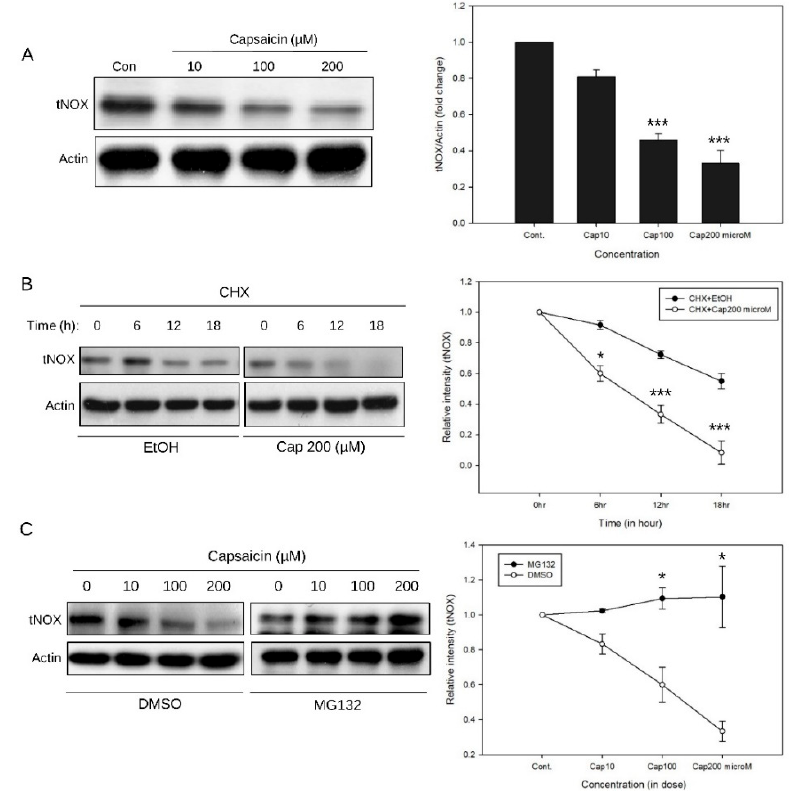
Figure 2. Capsaicin suppresses tNOX expression through proteasome-mediated degradation. Aliquots of cell lysates were separated by SDS-PAGE and analyzed by Western blotting. β -Actin was detected as an internal control. Representative images are shown. Values (mean ± S. E.) are from at least three independent experiments (* p < 0.05, *** p < 0.001 for capsaicin-treated cells vs. controls). ( A ) tNOX expression was significantly decreased by capsaicin at 100 and 200 µ M. ( B ) Capsaicin (200 µ M) clearly reduces tNOX stability as assessed with a cycloheximide-chase assay. ( C ) The proteasome inhibitor, MG132, reverses the capsaicin-induced suppression of tNOX expression.